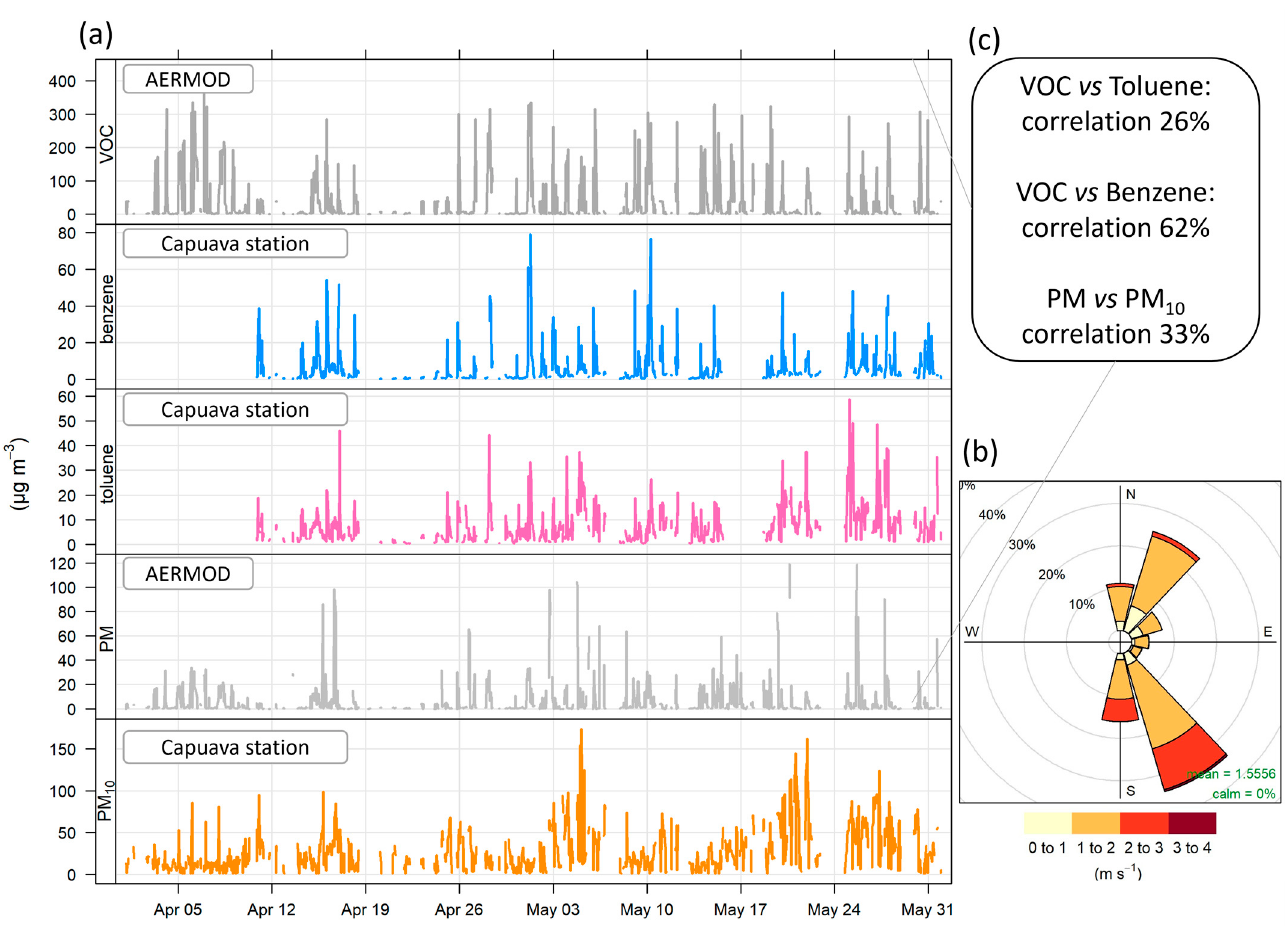
Figure 6. ( a ) Hourly mean concentrations for benzene, toluene, and PM 10 at Capuava AQS, VOC, and PM (AERMOD: modeled data) during the episode (April to May 2021), white spaces are missing values. ( b ) The wind rose shows the wind speed (m s − 1 ) and wind direction ( ◦ ), data were filtered by the preferential wind direction from the Capuava Petrochemical Complex (0 ◦ to 180 ◦ ) ( c ) “Correlation” is the correlation coefficient of Pearson.